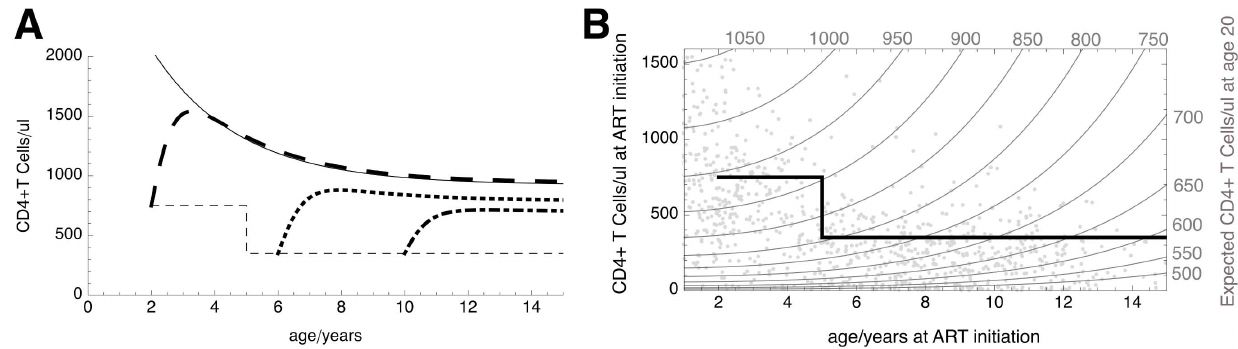
Figure 3. Predicted long-term CD4 counts in children starting ART at different ages and CD4 levels. (A) CD4 trajectories predicted for children starting ART having reached WHO CD4 count thresholds at age 2 (dashed line), 6 (dotted line), or 10 (dot-dashed line) y. The thin dashed line indicates WHO thresholds for ART initiation, and the thin solid line the trajectory in CD4 count with age expected in a healthy child. (B) Expected CD4 count on immunological maturity (estimated at age 20 y) for different ages and CD4 counts at ART initiation. Values at the ends of the grey contour lines indicate expected adult CD4 count in children starting ART at the ages and CD4 counts given on the horizontal and vertical axes. The black line indicates the current WHO CD4 thresholds for ART initiation. Grey point markers show the age and fitted CD4 count at ART initiation of the 914 children on whom the model is based. They indicate at which ages/CD4 counts the model has substantial evidence, and where it represents an extrapolation from the available data.